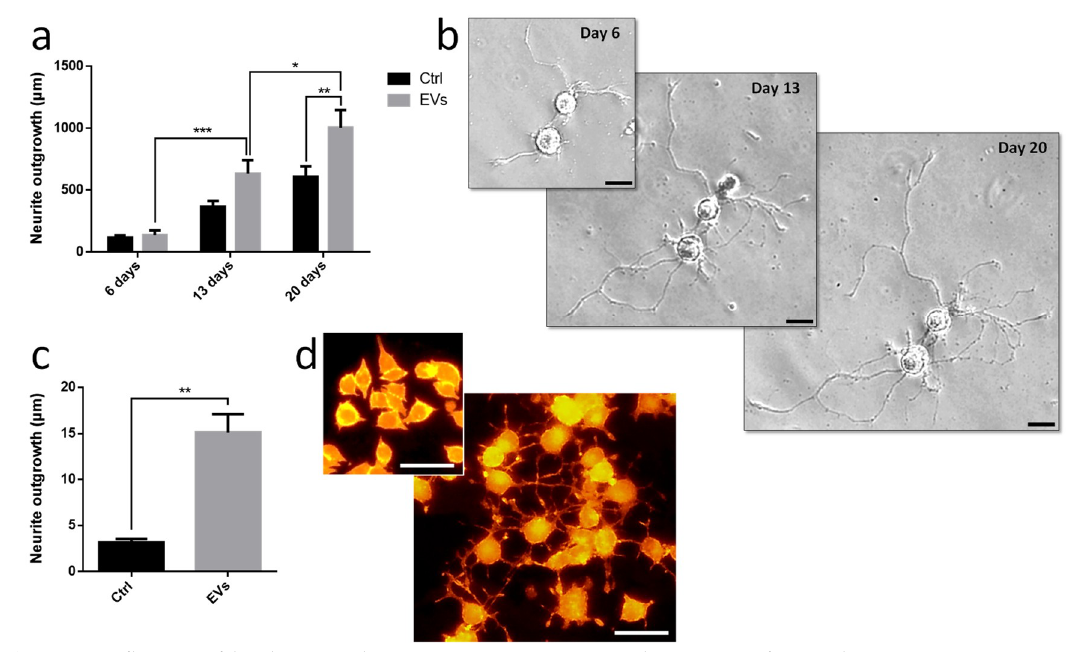
Figure 6. Influence of leech microglia EVs in neurite outgrowth assays. ( a , b ) Leech neurons were primarily cultured with either EV-enriched fractions or control supernatants from enrichment procedure. ( a ) The measures of neurite length were independently made on individual neurons at days 6, 13, and 20 showed a significant outgrowth throughout the culture under EVs and a higher outgrowth at day 20 in EV-activated condition compared to control. ( b ) The images show the same cells under EVs from day 6 to day 20. ( c , d ) Rat PC12 cells were cultured for only 7 days including a treatment at day 2 with either EV-enriched fractions or control supernatants. ( c ) The measures of neurite length were overall made on cell population and significantly showed a higher outgrowth under EVs compared to control. ( d ) The images show cells after 6 days treatment in control (top frame) and EV-activated (main frame) conditions. Scale bars correspond to 20 µm. Significance (* p < 0.05, ** p < 0.01, *** p < 0.001) was calculated by ANOVA paired t -test (bar represents standard errors of mean).